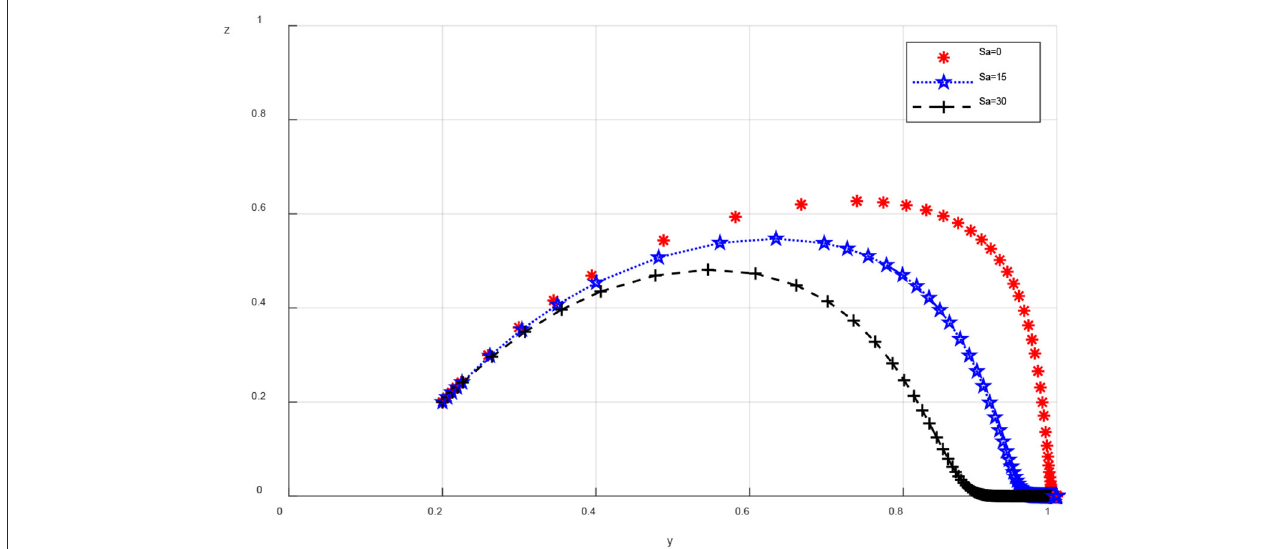
FIGURE9 Effect of the size of government subsidies to the recycling industry on the dynamic evolutionary outcomes of the game